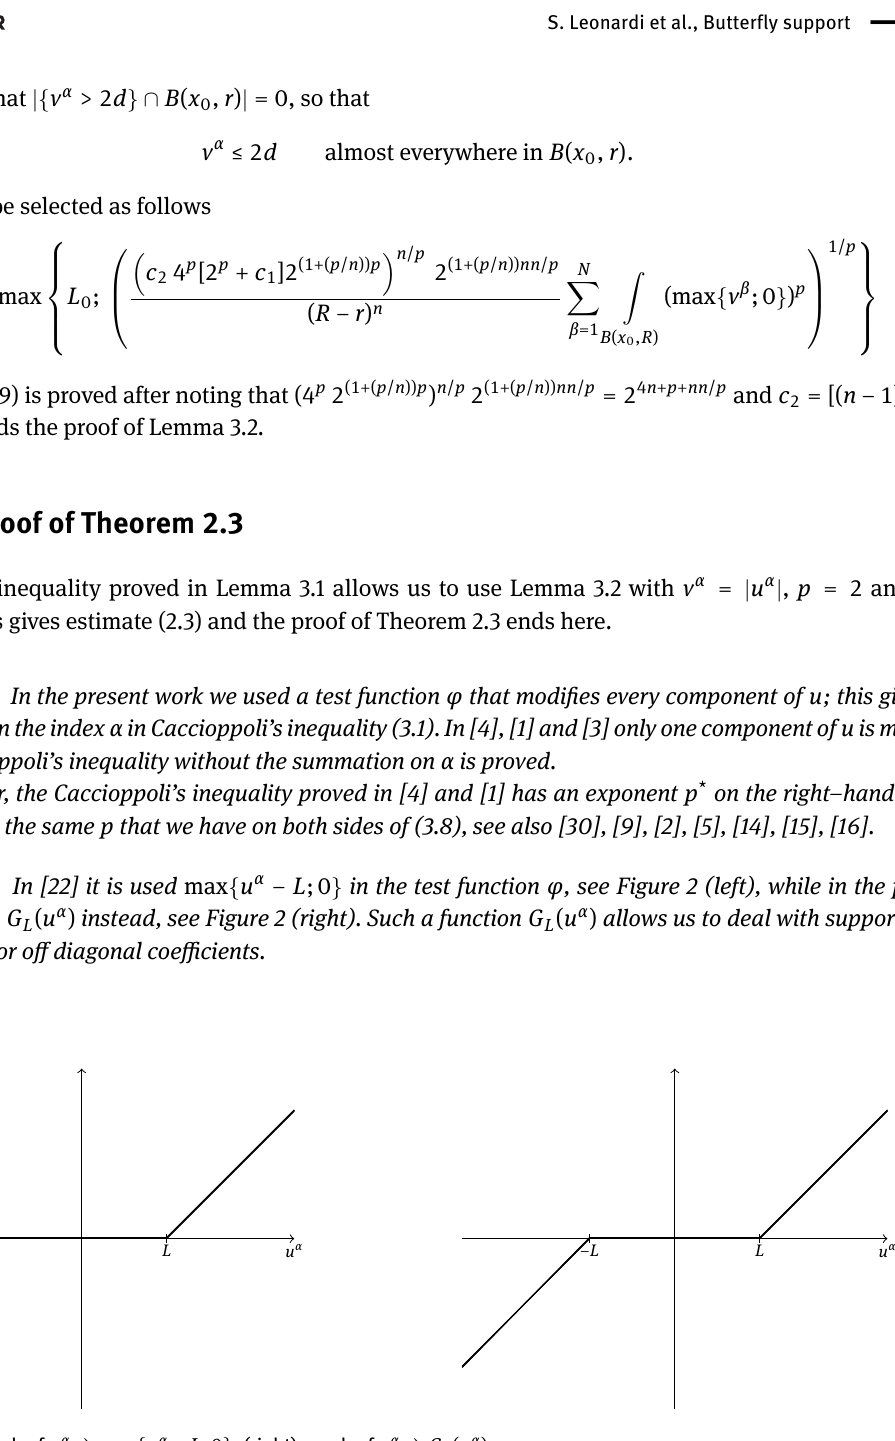
Fig. 2: (left) graph of u α → max { u α − L ;0 } ; (right) graph of u α → G L ( u α )